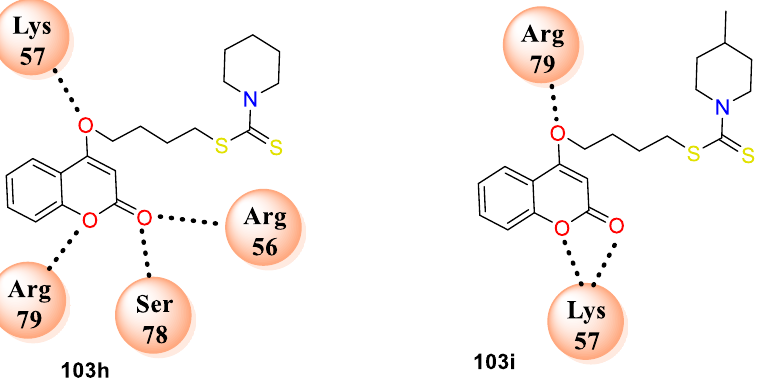
Figure 8. Hydrogen bonding interactions of compounds 103h and 103i with C. albicans DHFR (PDB ID: 1Al9).